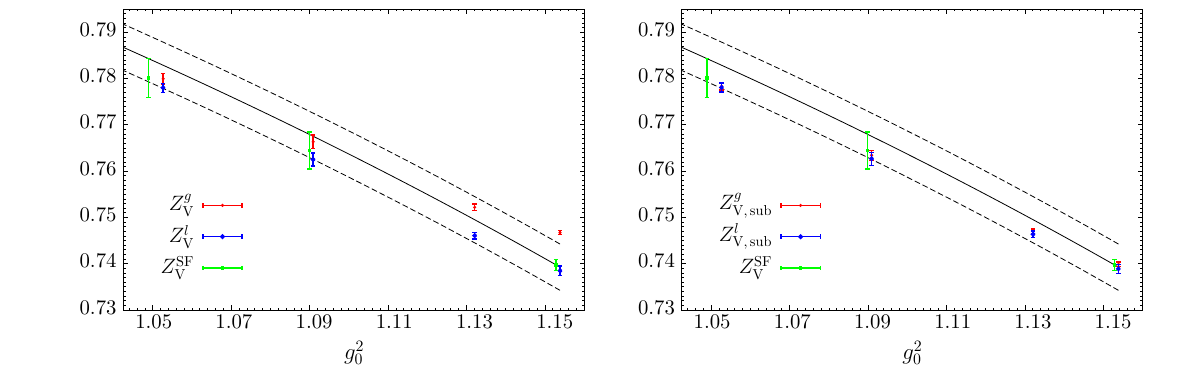
corresponds to the SF results from the fit formula of Ref. [21], and the dashed lines delimit the 1 σ region of the fit. Note that the SF fit for- mula is obtained by considering additional points with g 2 shown, and by enforcing the perturbative 1-loop behaviour for g 2 (see Ref. [21] for the